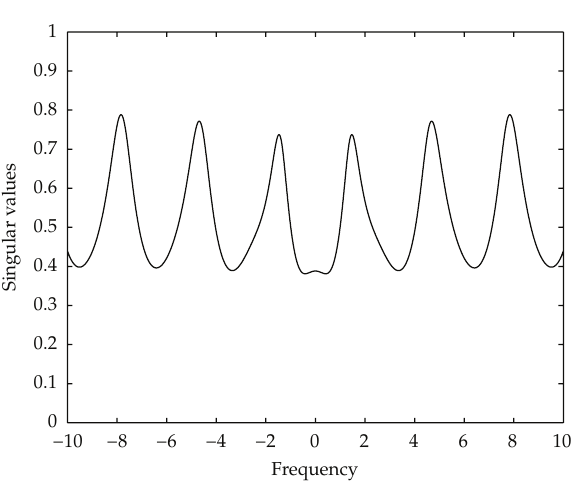
Figure 4: Singular value curve of the filtering error